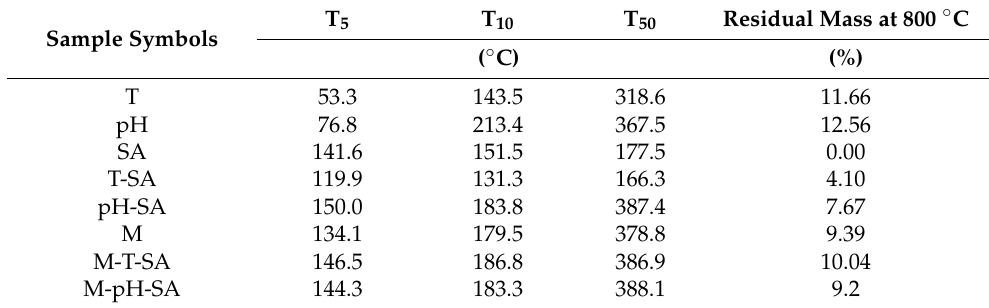
Figure 7. TG and DTG curves of the basic matrix (M) and thermo/pH-sensitive nanocarriers–salicylic acid systems. Table 3. Thermal properties of bio-hybrid hydrogels and substrates used for their production.